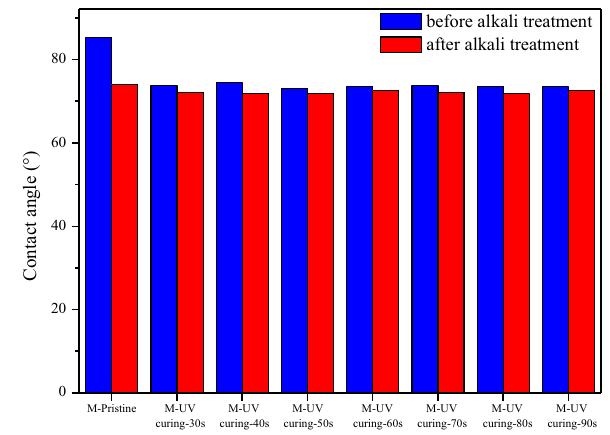
Fig. 8 The effect of alkali treatment on membrane contact